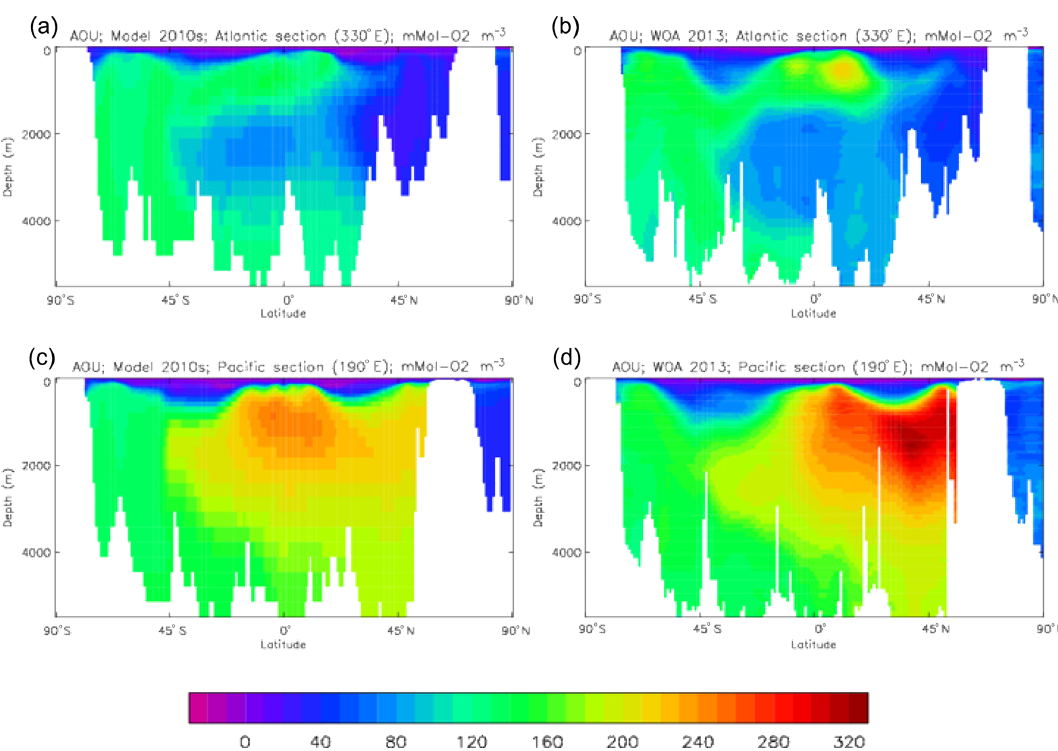
Figure 33. Meridional sections of apparent oxygen utilisation (mMolO 2 m − 3 ): panels (a) and (b) show sections in the Atlantic Ocean along 330 ◦ ; (c, d) Pacific Ocean sections along 190 ◦ . Panels (a) and (c) show model concentrations averaged over 2010–2019; panels (b) and (d) show concentrations from the 2013 World Ocean Atlas gridded field.